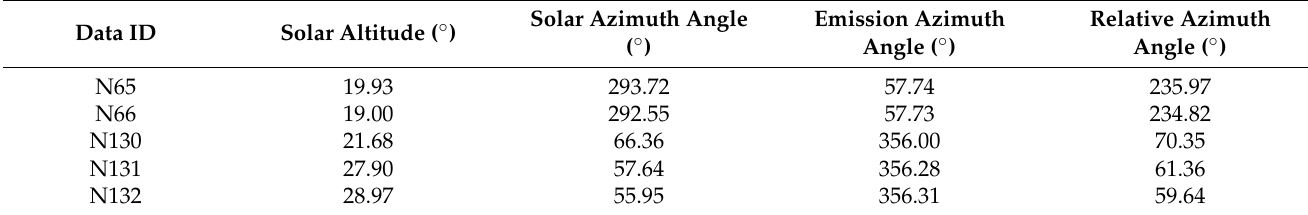
Table 2. Observation angles for data involving bright